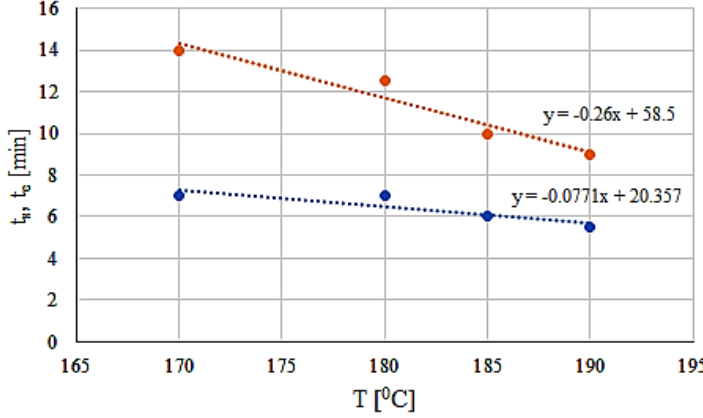
Figure 10. Graph of the dependence between the initial setting time t s and the final setting time t e of the synthetic gypsum in a function of its calcination temperature T.